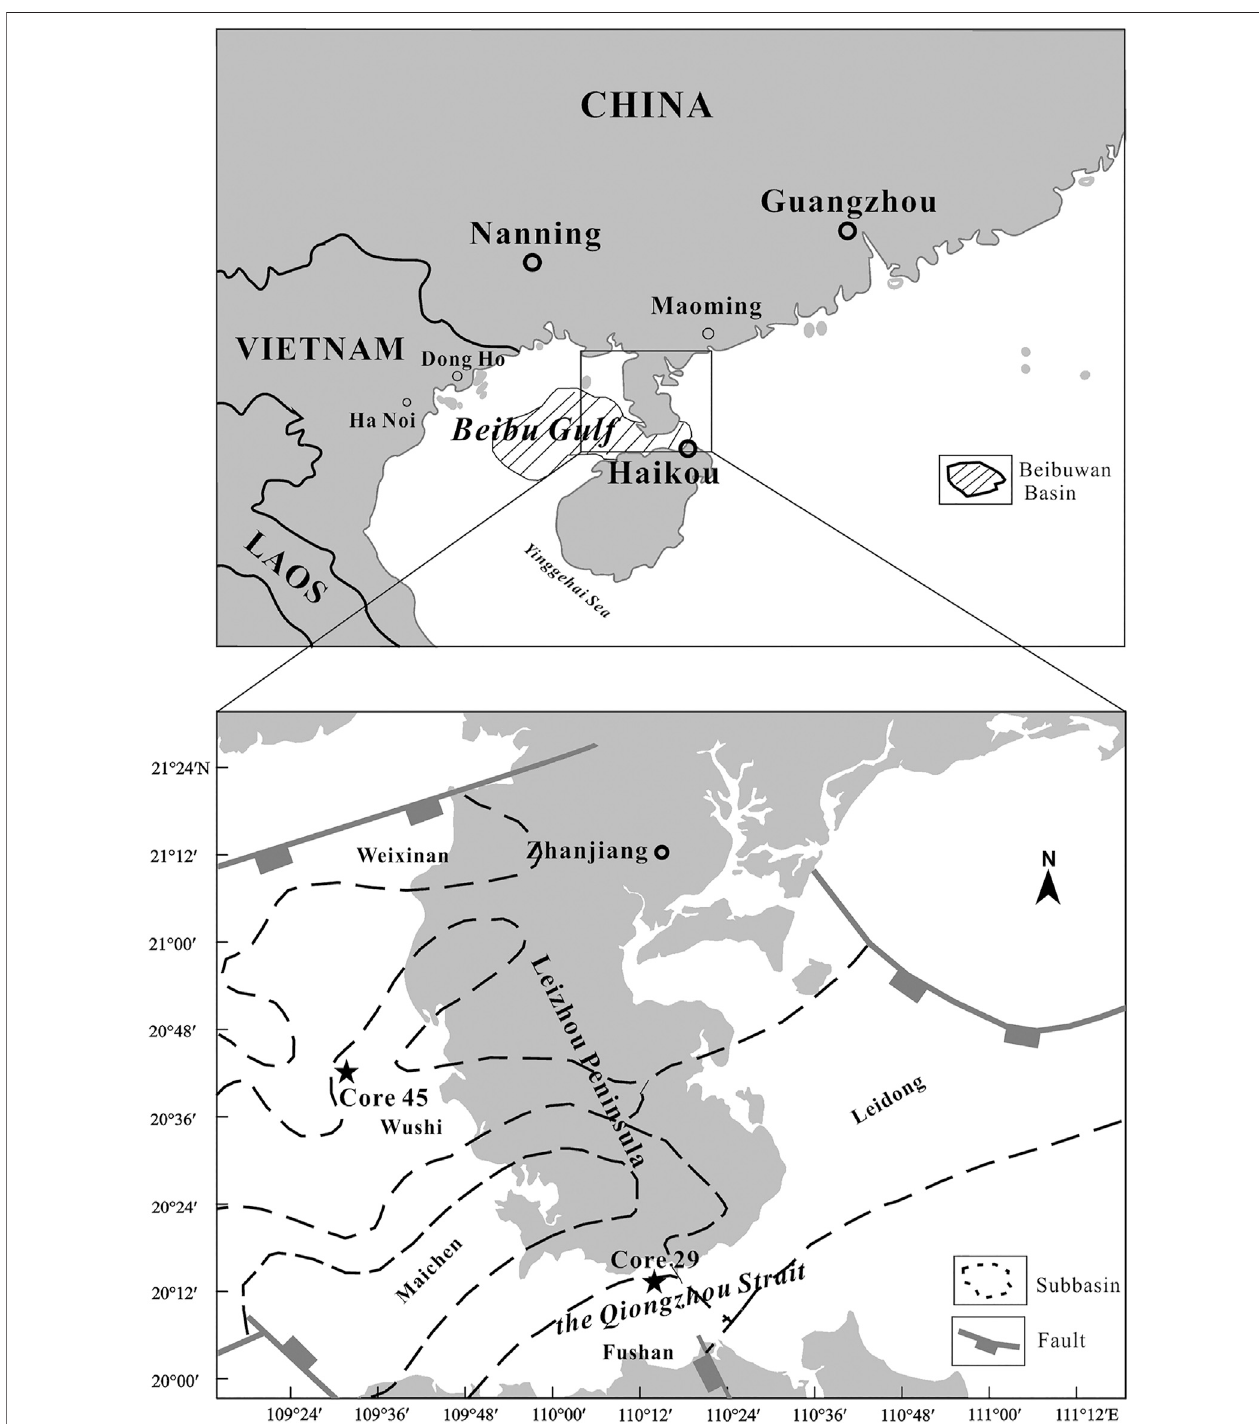
FIGURE 1 | Map of study area and sampling locations (modi fi ed after Huang et al., 2017).